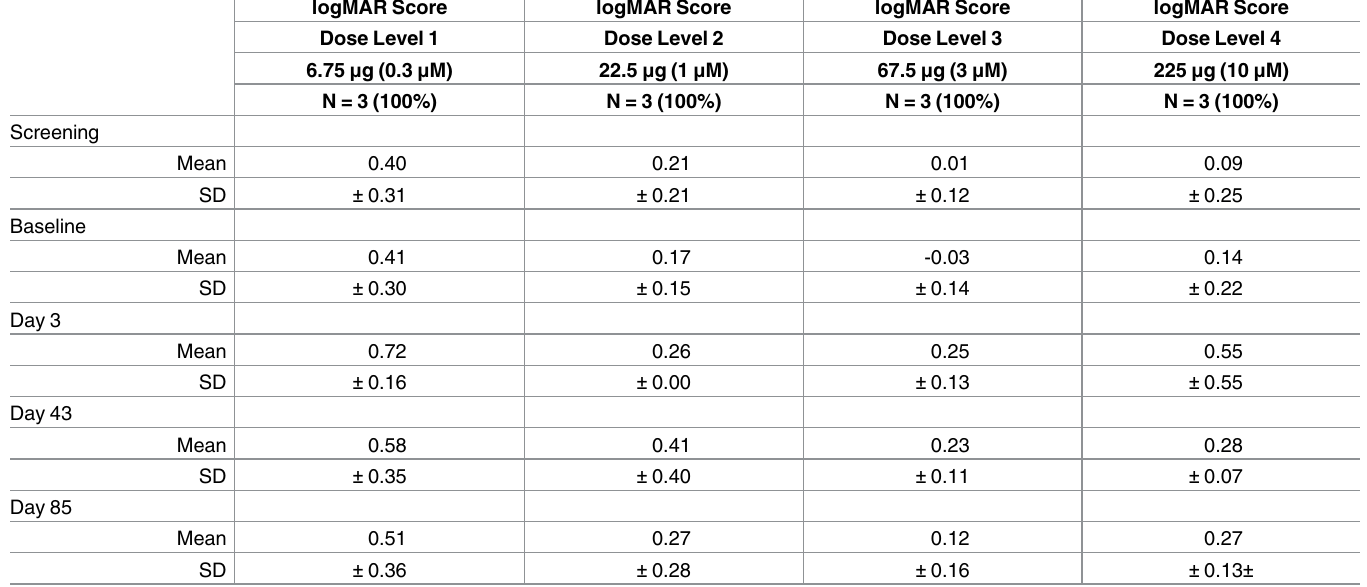
Table 6. Best corrected visual acuity (logMAR